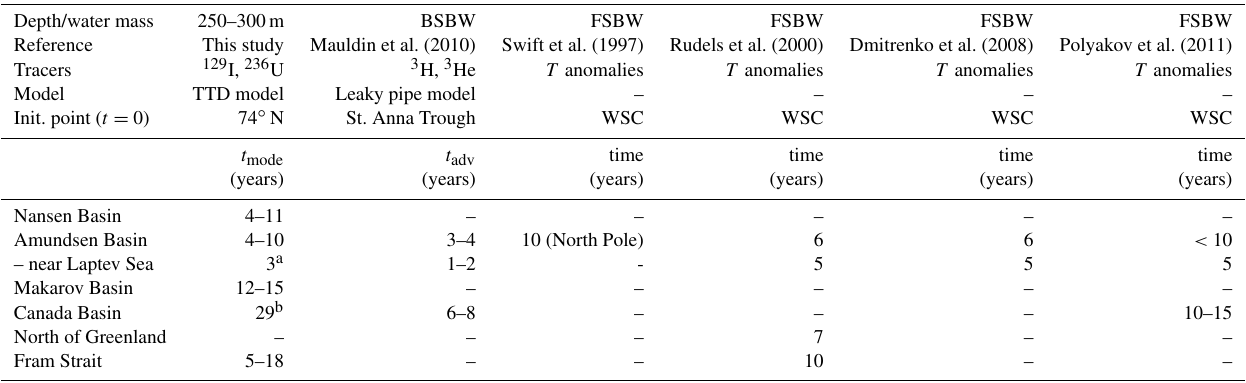
Table 3. Mode ages ( t mode ) determined from the TTD model for different basins of the Arctic Ocean in the Atlantic layer (250–300m depth) in comparison to circulation times from the propagation of hydrographic properties in the FSBW (data and modeling studies). Given ranges correspond to minimum and maximum values of stations within the basin, taking all sampling years into account. WSC: West Spitsbergen Current; T : temperature; Init. point: initialization